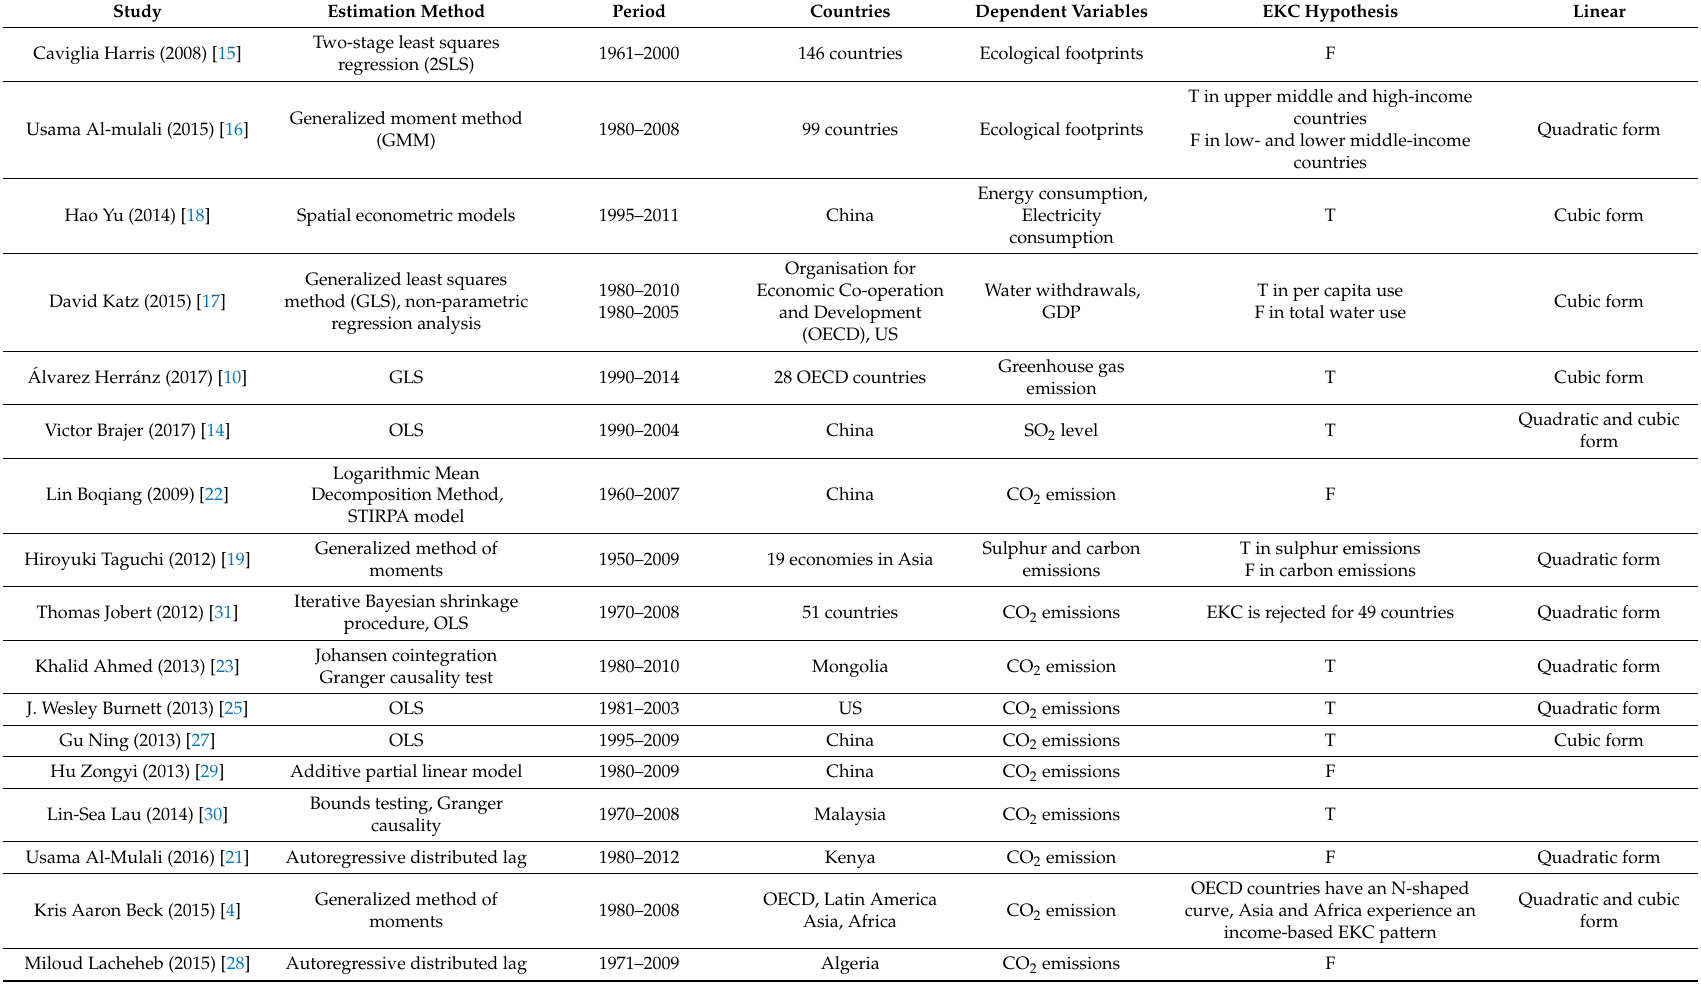
Table 1. Overview of the selected